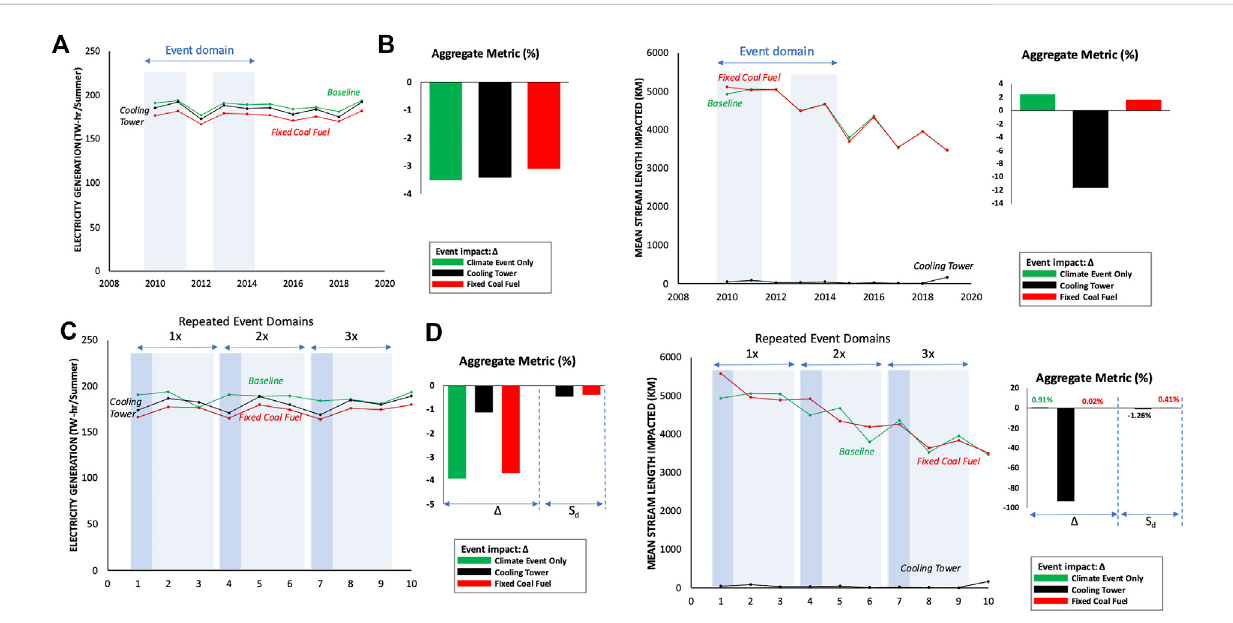
FIGURE 4 (A) and (B). Model simulation timeseries and climate sensitivity statistics for aggregate power production and associated thermal pollution, respectively, acrosstheMWasaresultoftheimposed2012heatwave(Table3).ThepanelseachshowBaselineandtwoncSFE(non-climatesinglefactor experiment)scenarios,i.e.,removingallcoolingtowersand fi xingthefuelsourceforallpowerplantstocoal.ClimatesensitivitymetricsuseEqs1,2under climate experimentApproach (A) (C) and (D). Show analogous results, but with impositionof three sequential heat waves under climateexperiment Approach (B) . The aggregate regional metrics use variants of Eqs 3, 4 to capture the overall effect of the single cSFE (climate single factor experiment), climate with an additional non-climate factor (constituting with climate effects, an MFE), and attempting to isolate the individual impact of climate under the combined scenarios (S d ); see Section